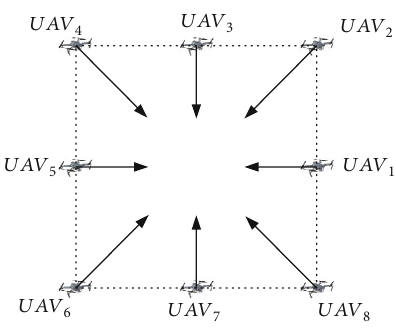
Figure 7: Con fl ict scene in the square airspace. Table 2: Simulation parameter setting. Figure 5: Classic 6 aircraft-to- fl ight con fl ict